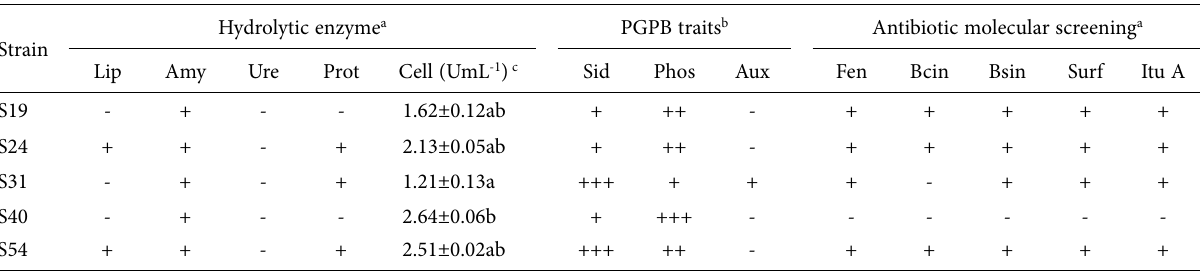
Table 2. Modes of action of selected antagonistic bacteria in dual culture assays with Phytophthora citrophthora.